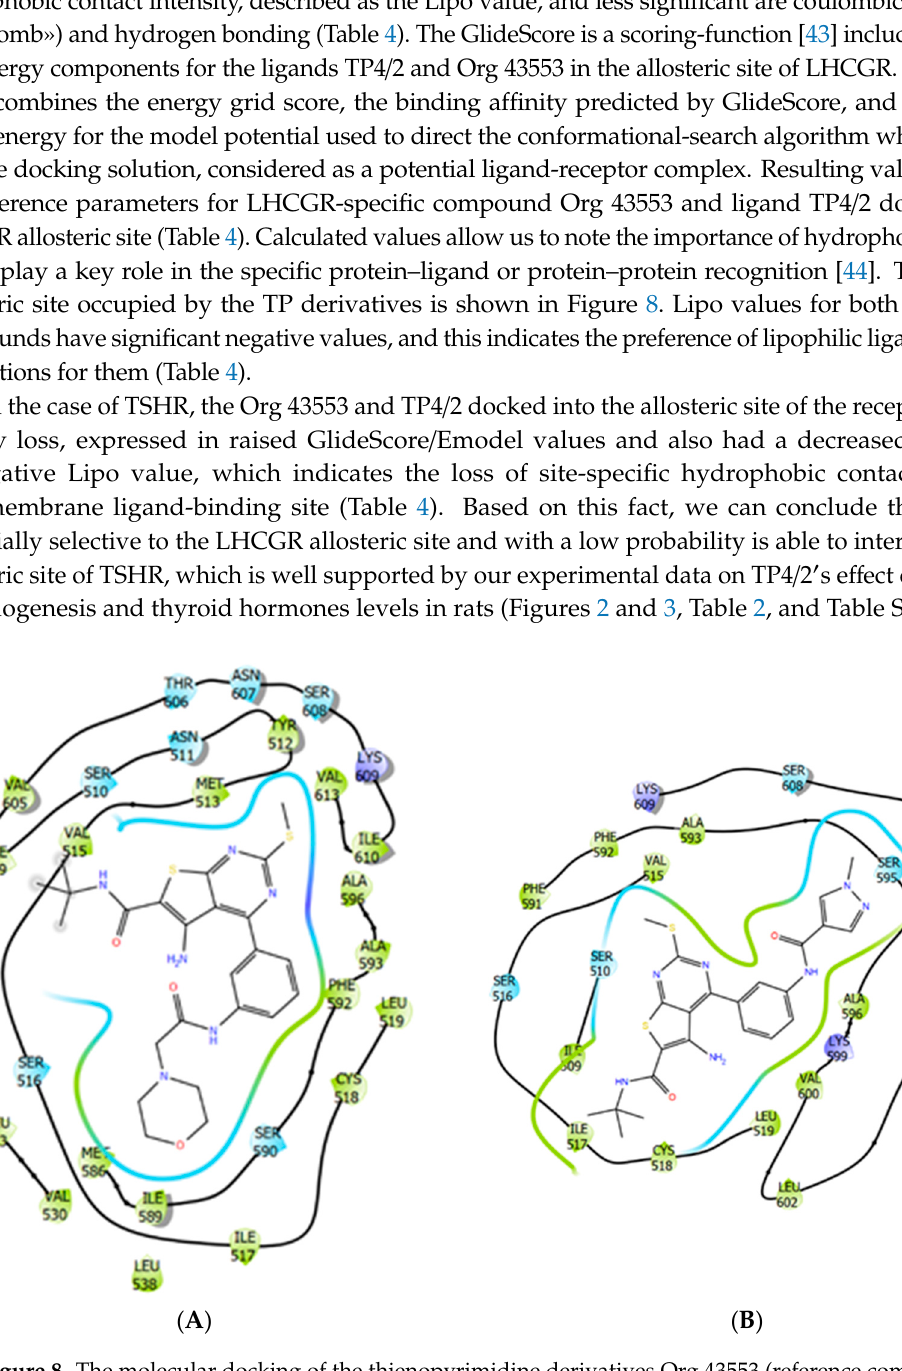
Figure 8. The molecular docking of the thienopyrimidine derivatives Org 43553 (reference compound) ( A ) and TP4/2 (testing compound) ( B ) into the allosteric site of rat LHCGR. Amino acid residues with the hydrophobic (in green), positively charged (in violet) or polar groups (in blue) are shown. The same colors are used to indicate contacts between the allosteric agonist and the surface of the LHCGR allosteric site. Table 4. The GlideScore, Emodel and Lipo/Coulomb/H-bond values resulting from molecular docking study of the compounds Org 43553 and TP4/2 into the transmembrane allosteric sites of rat LHCGR and TSHR.